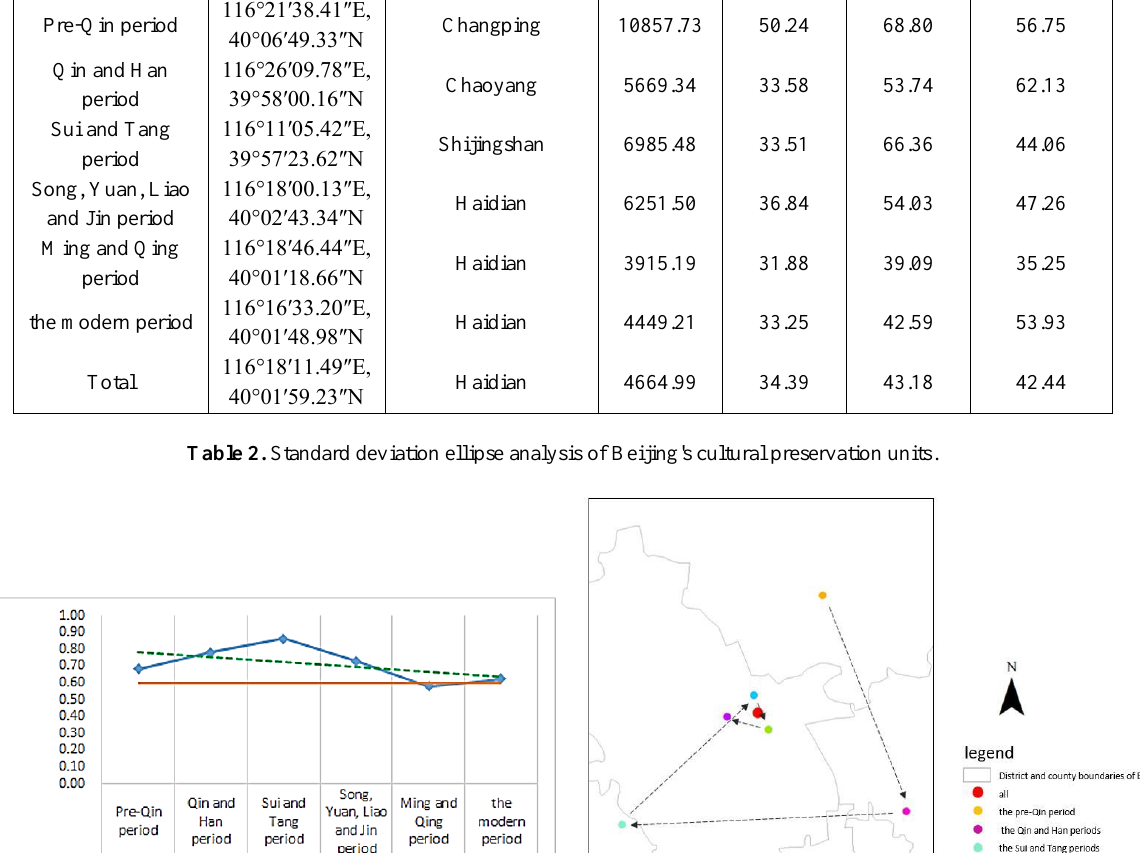
Figure 8. Shifting center of gravity of the distribution of cultural preservation units in